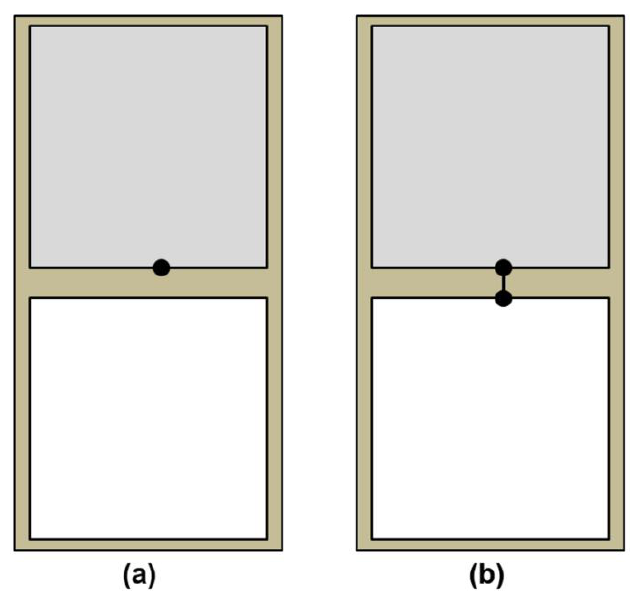
Figure 3. An OSM node (black circle) representing a door between to rooms ( a ) and the additional node (projected to the adjacent polygon) with an additional edge connecting them ( b